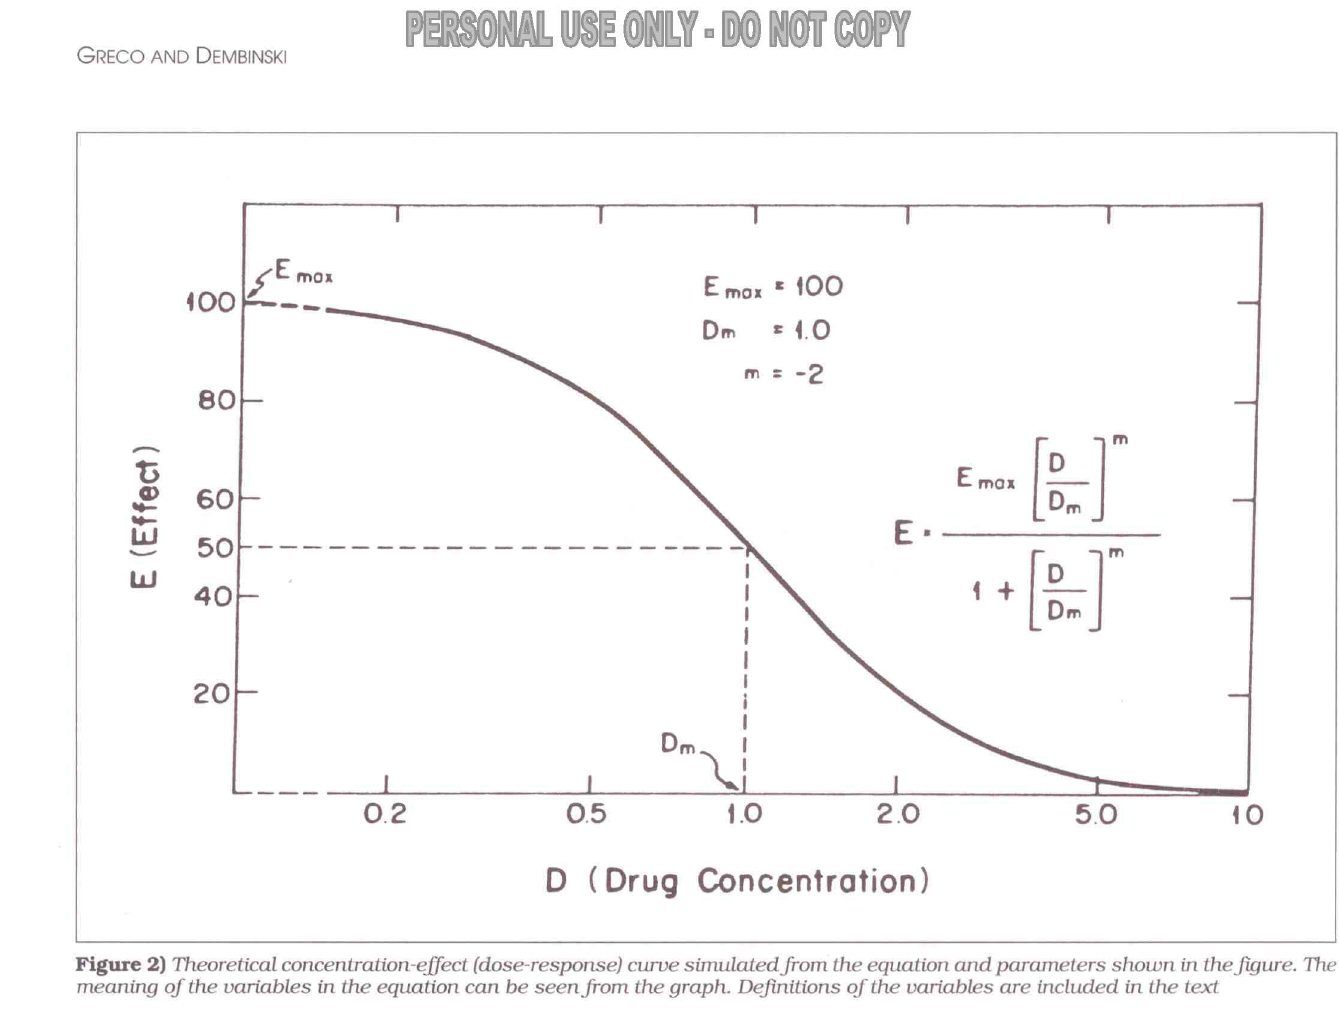
Figure 2) TheoreticaL concentration-effect (dose-response) curve simuLated .from the equation and parameters shown in the Jwure. The meaning of the variabLes in the equation can be seen from the graph. Definitions of the variables are incLuded in Lhe